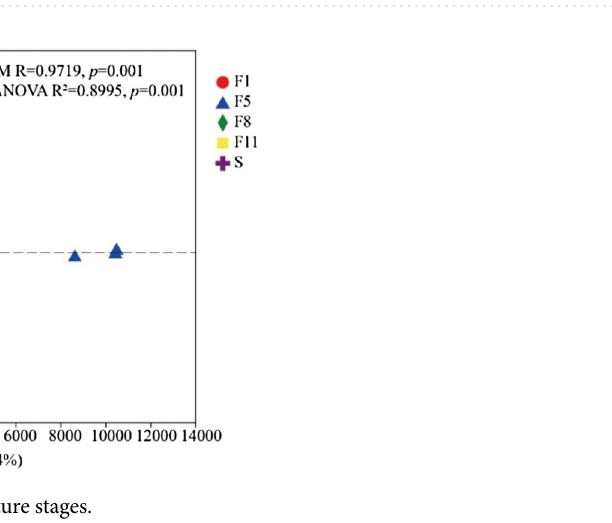
Figure 4. The ( a ) Ace index, ( b ) Simpson index, ( c ) Shannon index and ( d ) Sobs index in OUT level at different culture stages.